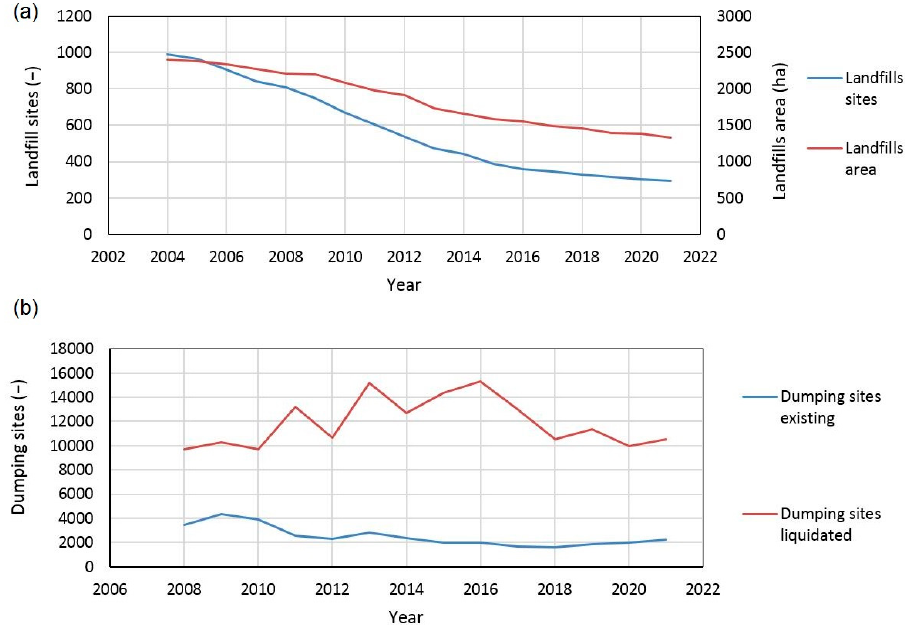
Figure 10. Waste management in rural areas of Poland, data obtained from [66]: ( a ) number and area of rural landfill sites in 2004–2021, ( b ) illegal rural waste dumping sites,